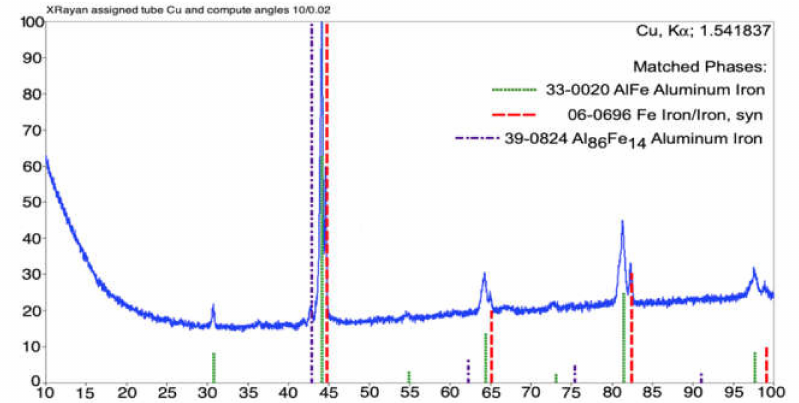
Figure 10. XRD diffraction pattern of the arc-sprayed Fe-Al coating after 800 ◦ C annealing.